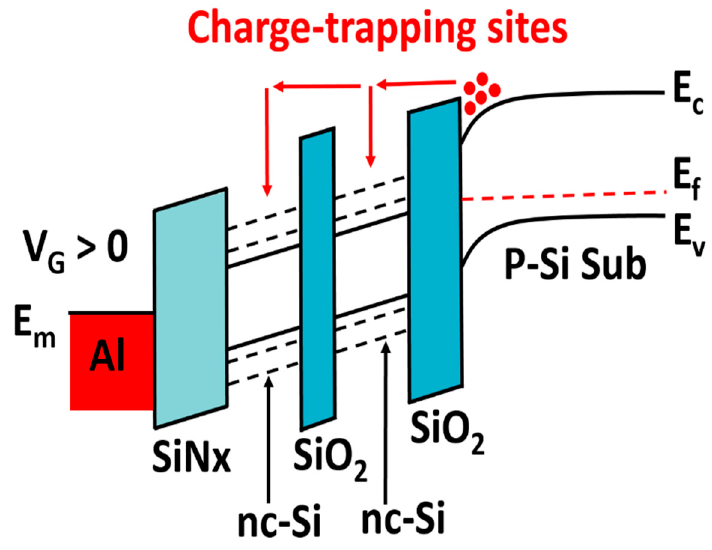
Figure 4. Energy band diagram of double-layer quantum dot floating-gate structure.